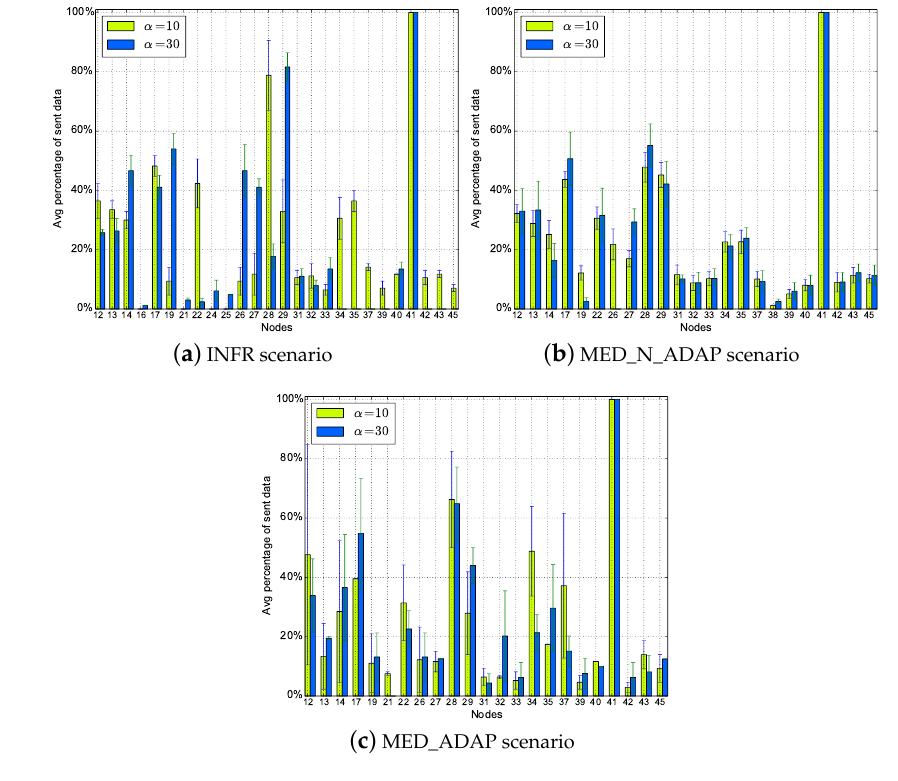
Figure 12. Average percentage of sent data packet per node.